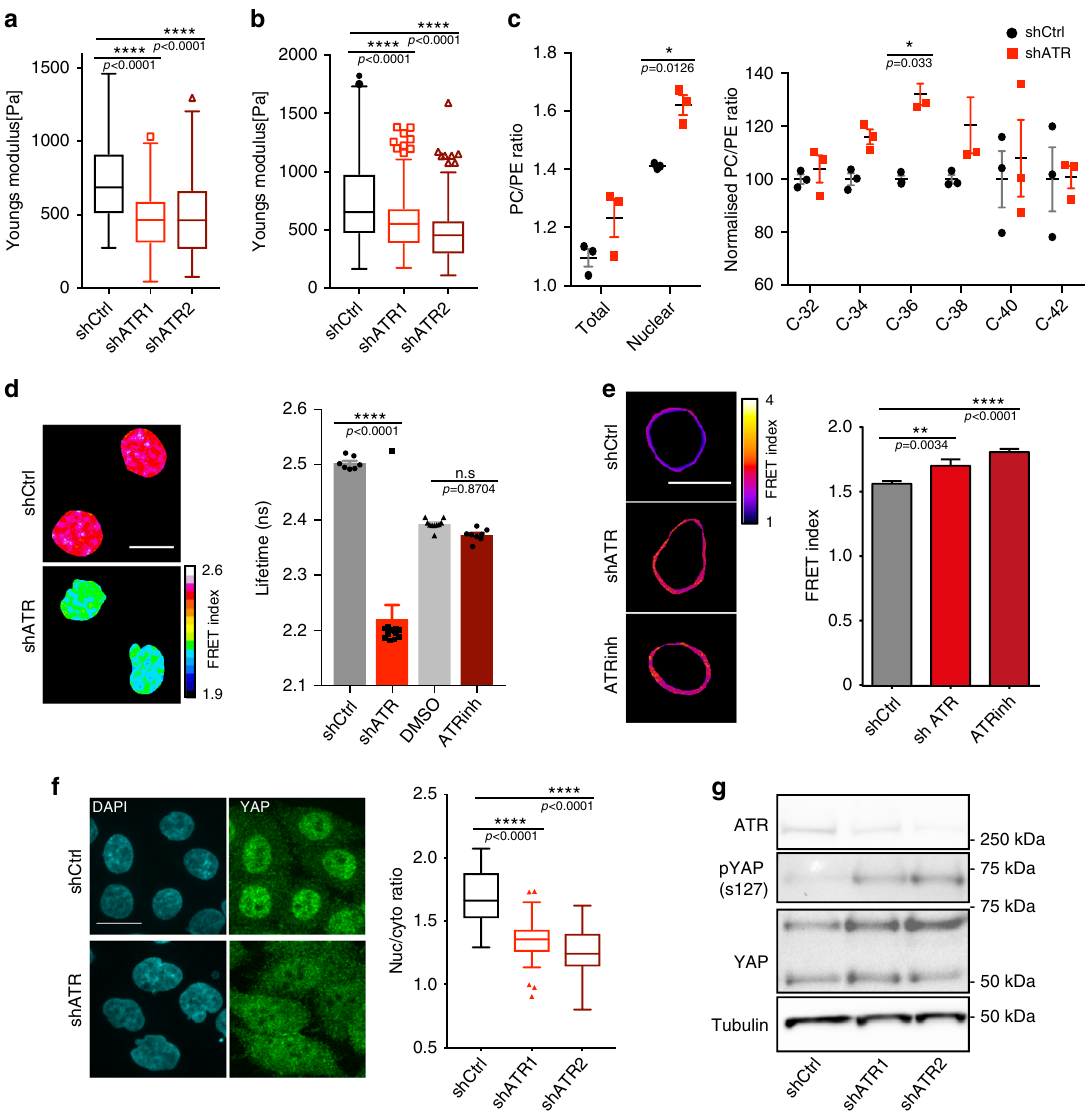
Fig. 2 ATR preserves nuclear mechanics. a , b Elastic modulus measurements using AFM. a Cellular stiffness ( n = 171, 161, and 179 measurements for shCtrl, shATR1, and ShATR2, respectively) and b stiffness of isolated nuclei from control and ATR-depleted cells ( n = 144, 110, and 98 measurements; N = 2 independent experiments). c Membrane phospholipid composition analysis; total cell and nuclear membrane PC/PE ratio, nuclear PC/PE ratio of individual species (from three biological and two technical replicates; two-way ANOVA test; Bonferroni ’ s multiple comparisons test; N = 2